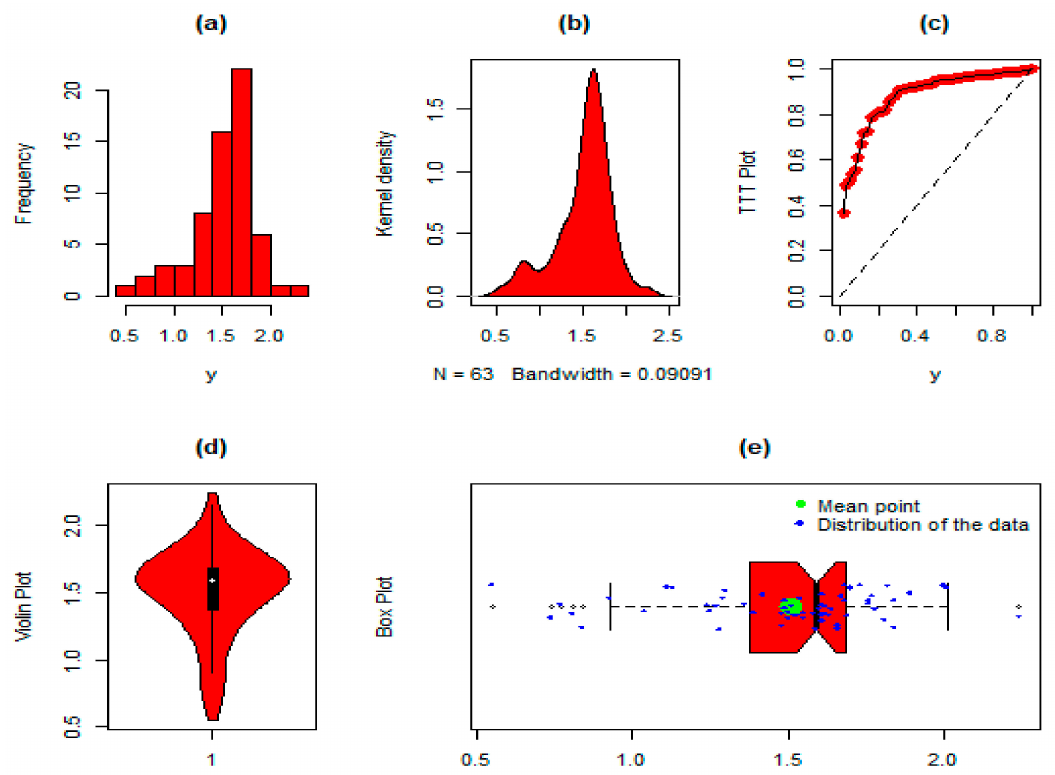
Figure 11. The ( a ) Histogram, ( b ) Kernel density plot, ( c ) TTT plot, ( d ) Violin plot, and ( e ) box plot for Data 1. Table 3. The values of using glass fiber data set (Data 1).